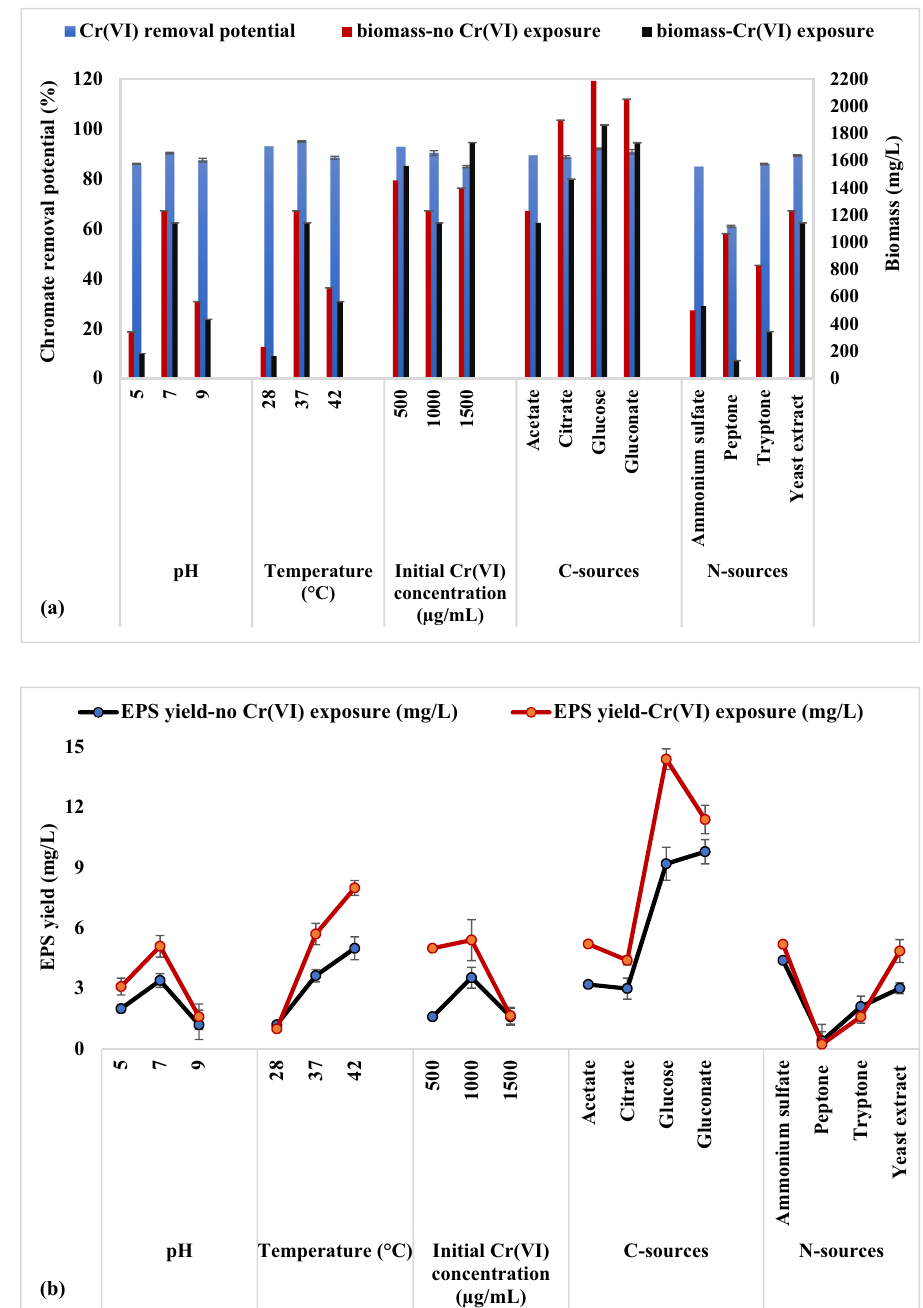
Figure 4: Evaluation of various pH, temperature, initial chromate concentration, carbon, and nitrogen sources on ( a ) biomass production and Cr ( VI ) removal potential and ( b ) EPS yield under various parametric conditions by bacterial strain